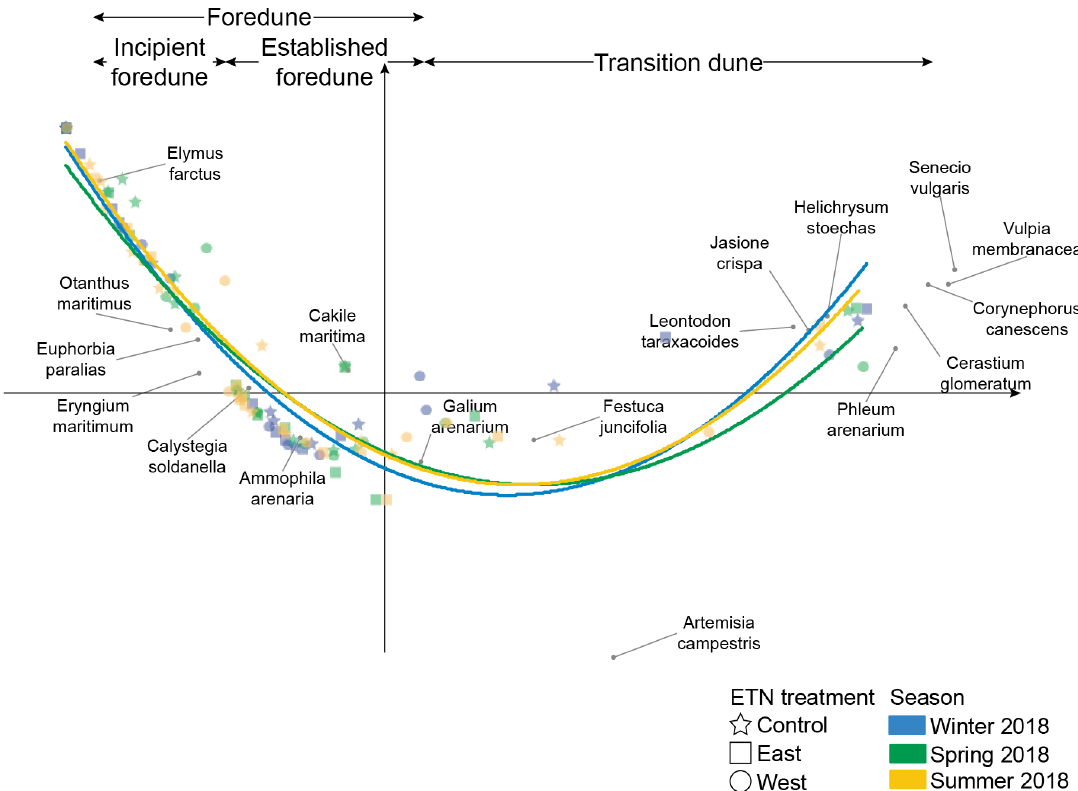
Figure A1. Correspondence analysis 1–2 diagram for vegetation quadrats, where axis 1 plant species coordinates were used to calculate the stability index. Extracted from [40].